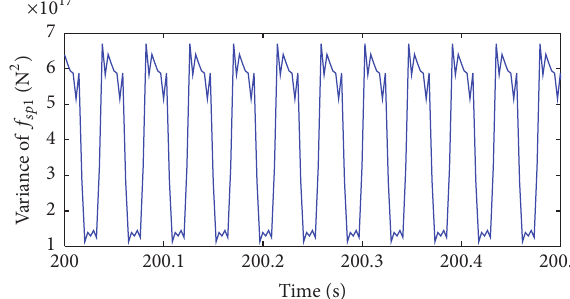
Figure 6: Variances of 𝑢 𝑐 , carrier rotation displacement. Figure 7: Variances of 𝑓